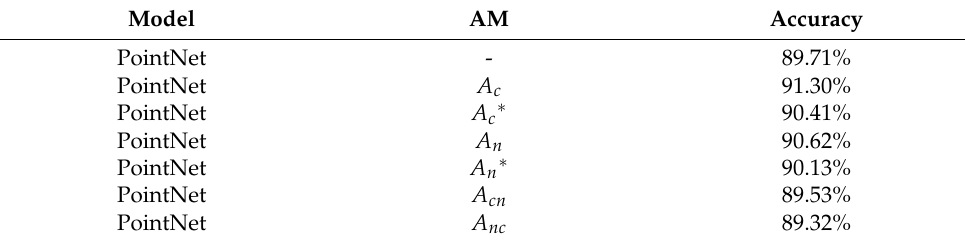
Table 2. Effect of attentional mechanisms on model